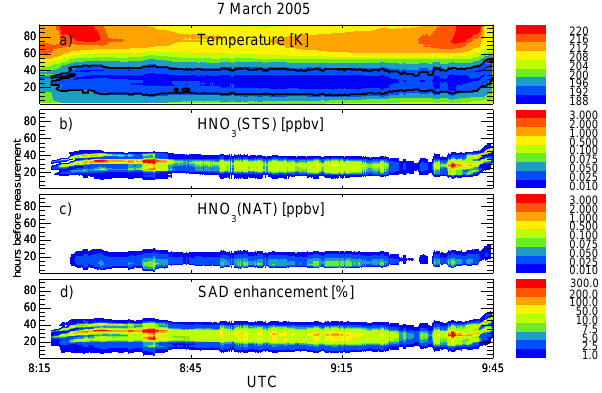
Fig. 3. Temperature history (a) , simulated condensation of HNO 3 on STS (b) , NAT (c) and corresponding enhancement of the sur- face area density over the background aerosol (d ) along 92 h back- trajectories ending on the Geophysica flightpath on 7 March 2005. Areas under T NAT are enclosed by the black